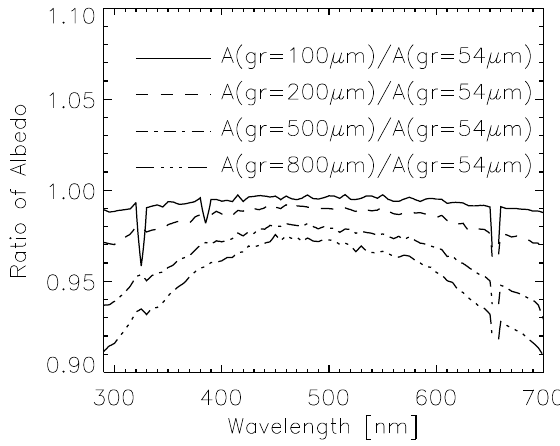
Fig. 11. Ratios of snow albedo (A) modelled with different grain size radii. The larger the grain size, the lower the albedo. The local minima are due to Mie scattering processes.